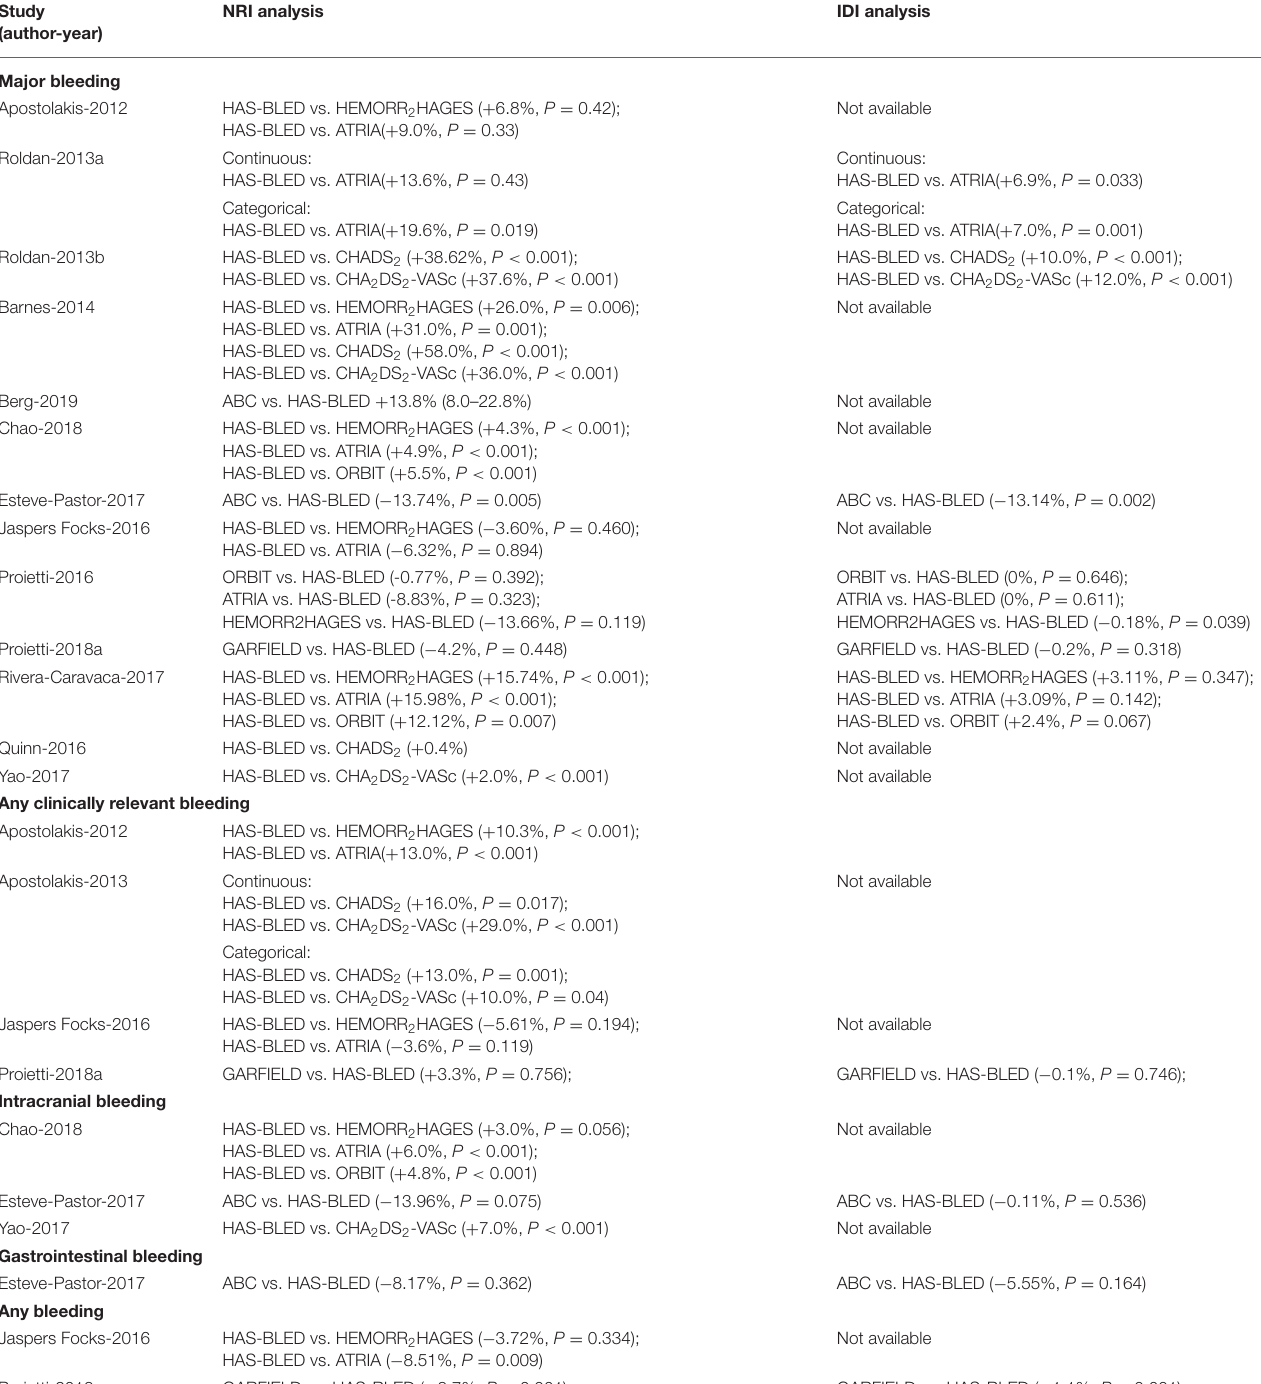
TABLE 3 | NRI and IDI analysis for predicting the bleeding risks in anticoagulated patients with